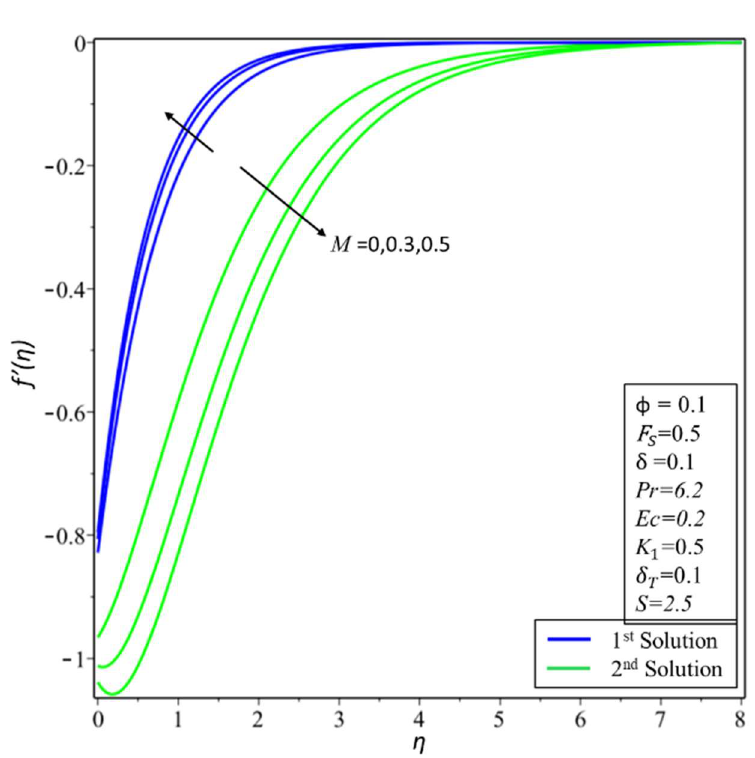
Figure 4. Changes of 𝑓′(𝜂) for 𝑀 .